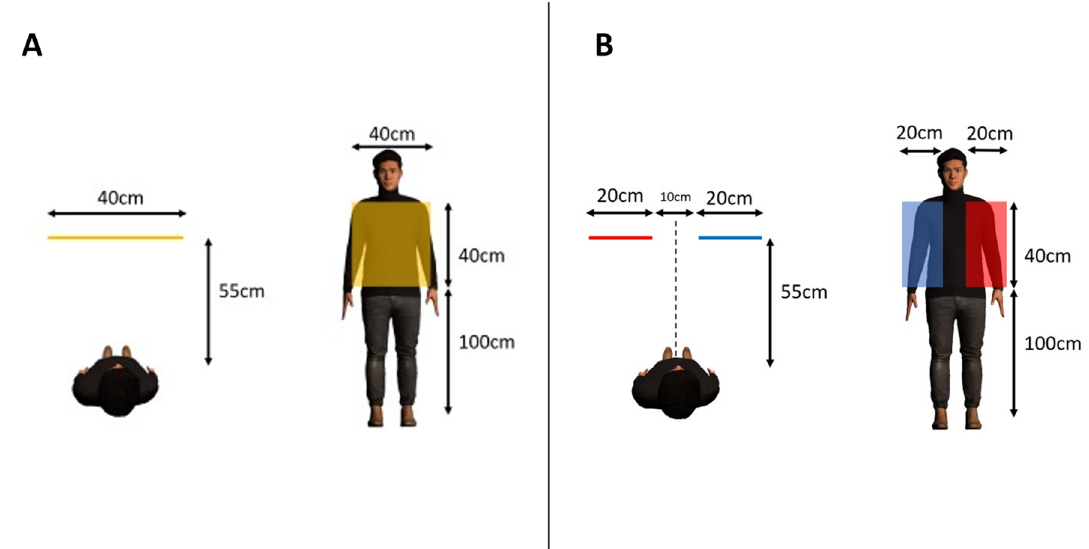
Figure 7. Target areas in each condition. ( A ) In the Same goal condition, yellow targets appeared at random positions inside the area shown in yellow. ( B ) In the different goals: visible and different goals: invisible conditions, the red targets that were to be reached with the left hand of the joint avatar appeared at random positions inside the area shown in red, and the blue targets that were to be reached with the right hand of the joint avatar appeared at random positions inside the area shown in blue.